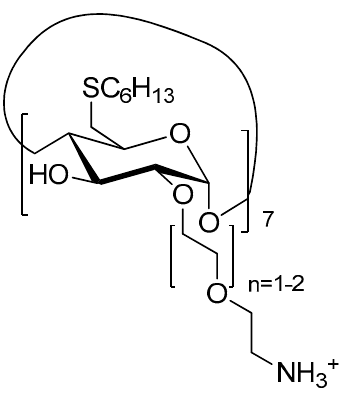
Figure 35. Chemical structure of SC 6 - β -CD-NH 2 vesicles.